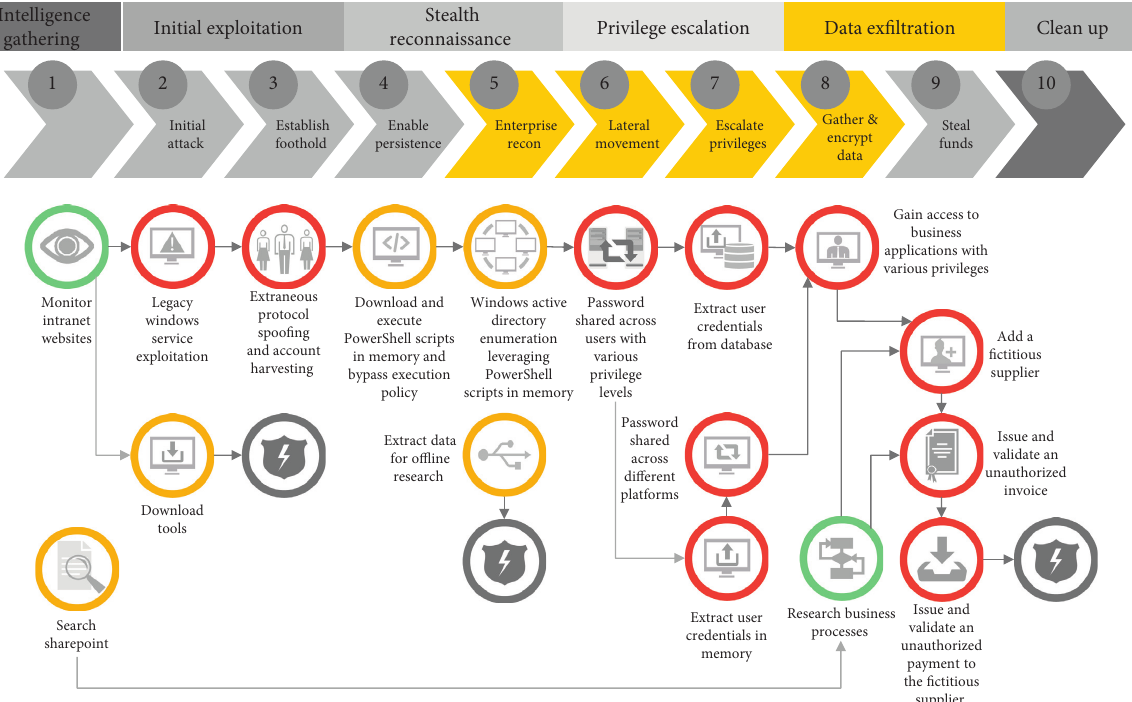
Figure 1: The common structure of subway traction system. The specific process is shown in title and